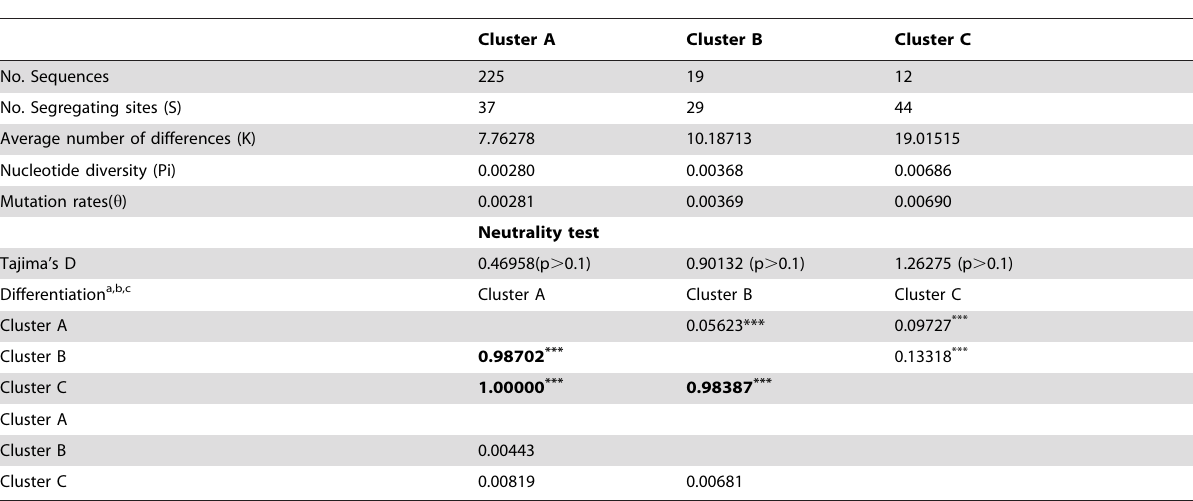
Table 2. Divergence and differentiation among